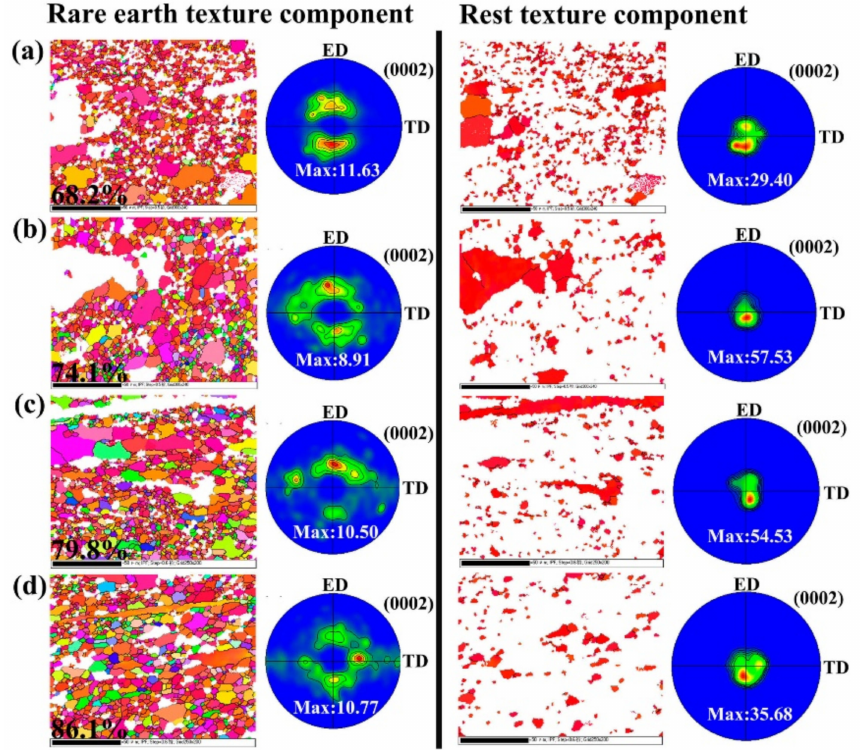
Figure 7. Rare earth texture components of the four as-extruded alloys: ( a ) TX10 alloy. ( b ) TXZ100 alloy. ( c ) TXZ101 alloy. ( d ) TXZ102